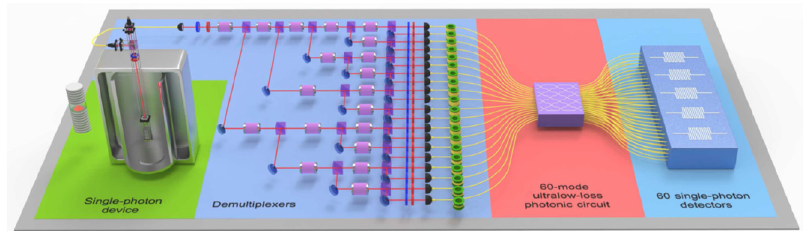
Figure 2: Experimental setup of boson sampling using 20 photons. The setup includes four key parts, that is, a single- photon device, demultiplexers, a photonic circuit, and SNSPDs. Reproduced